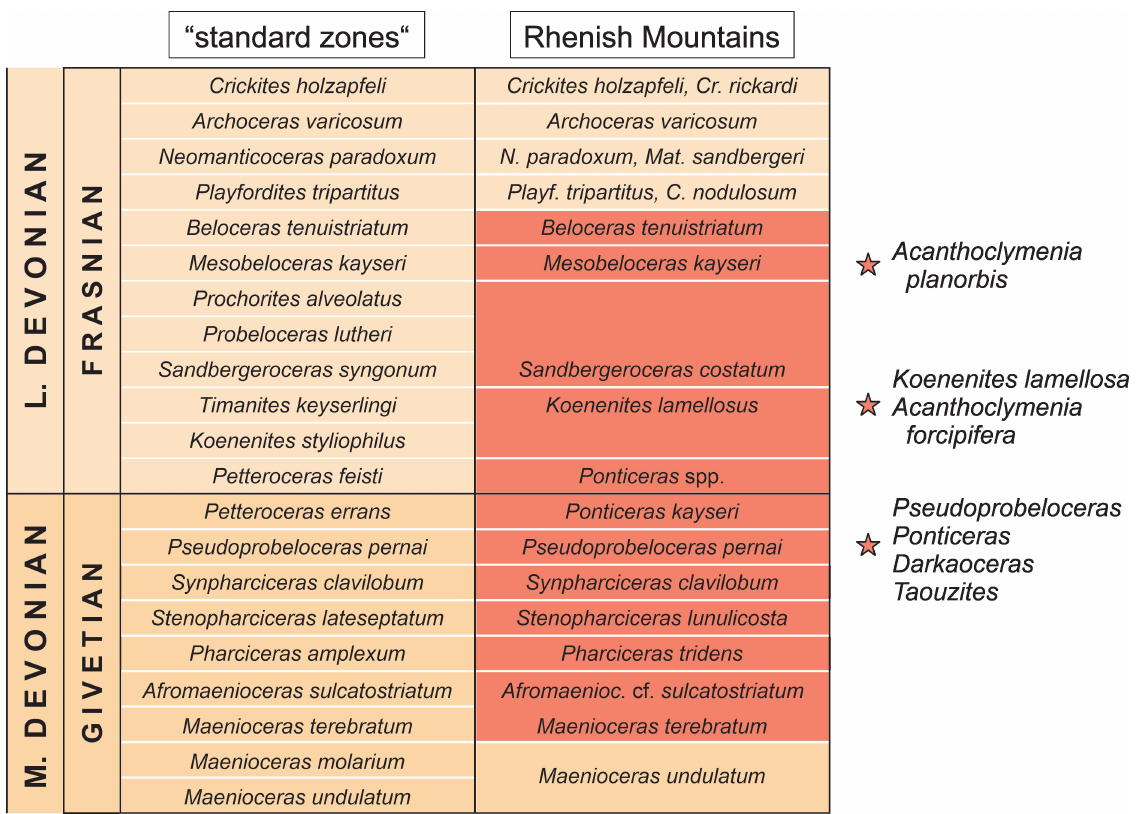
Fig. 2. Givetian and Frasnian ammonoid stratigraphy (after Becker & House 2000), probable extent of the Red Ironstone of Dillenburg and probable position of the ammonoid assemblages described